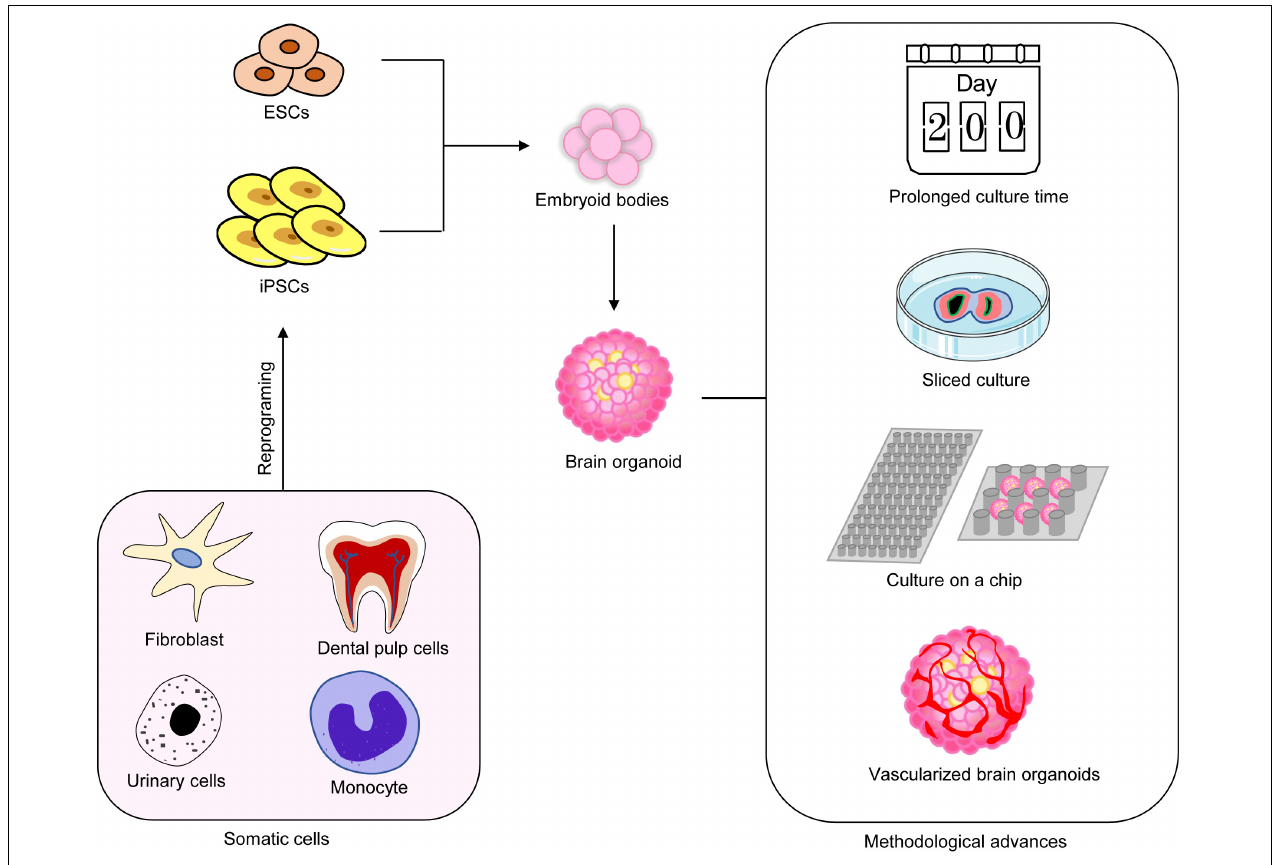
FIGURE 1 | Recent methodological advances in brain organoids. Multiple methods have been used to improve the maturation of brain